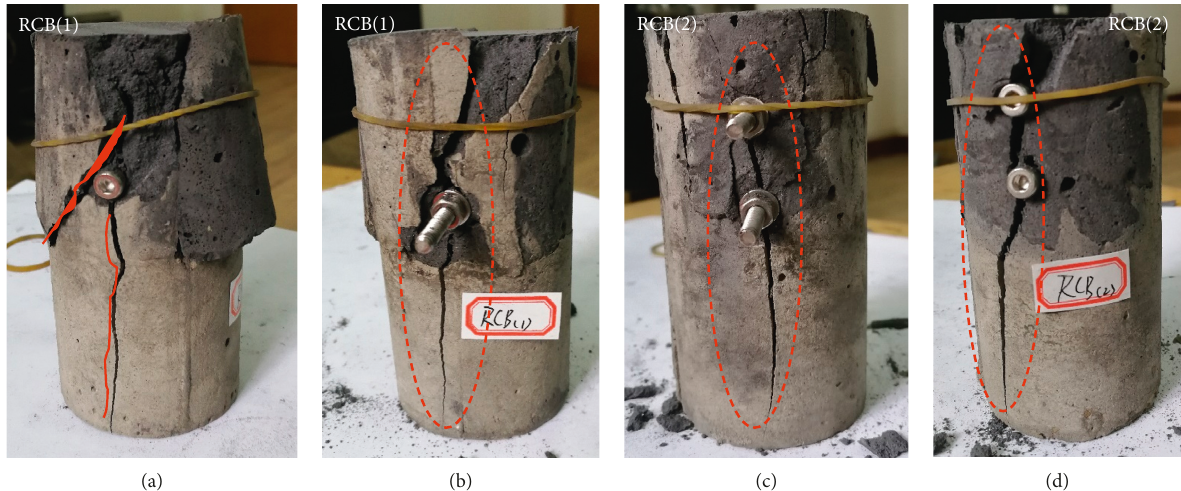
Figure 10: The failure law of the RCB(1 ∼ 2) specimen under combined loading